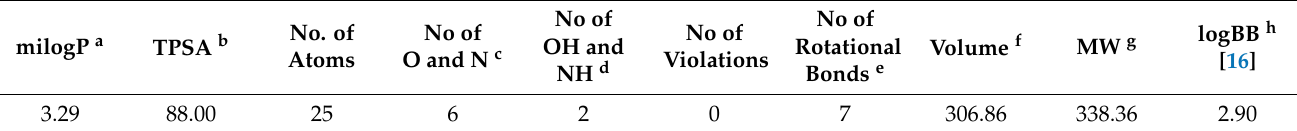
Table 1. Drug likeness of the synthesized oxime 5 . Molecular properties prediction-Lipinski “Rule of five”. milogP a TPSA b